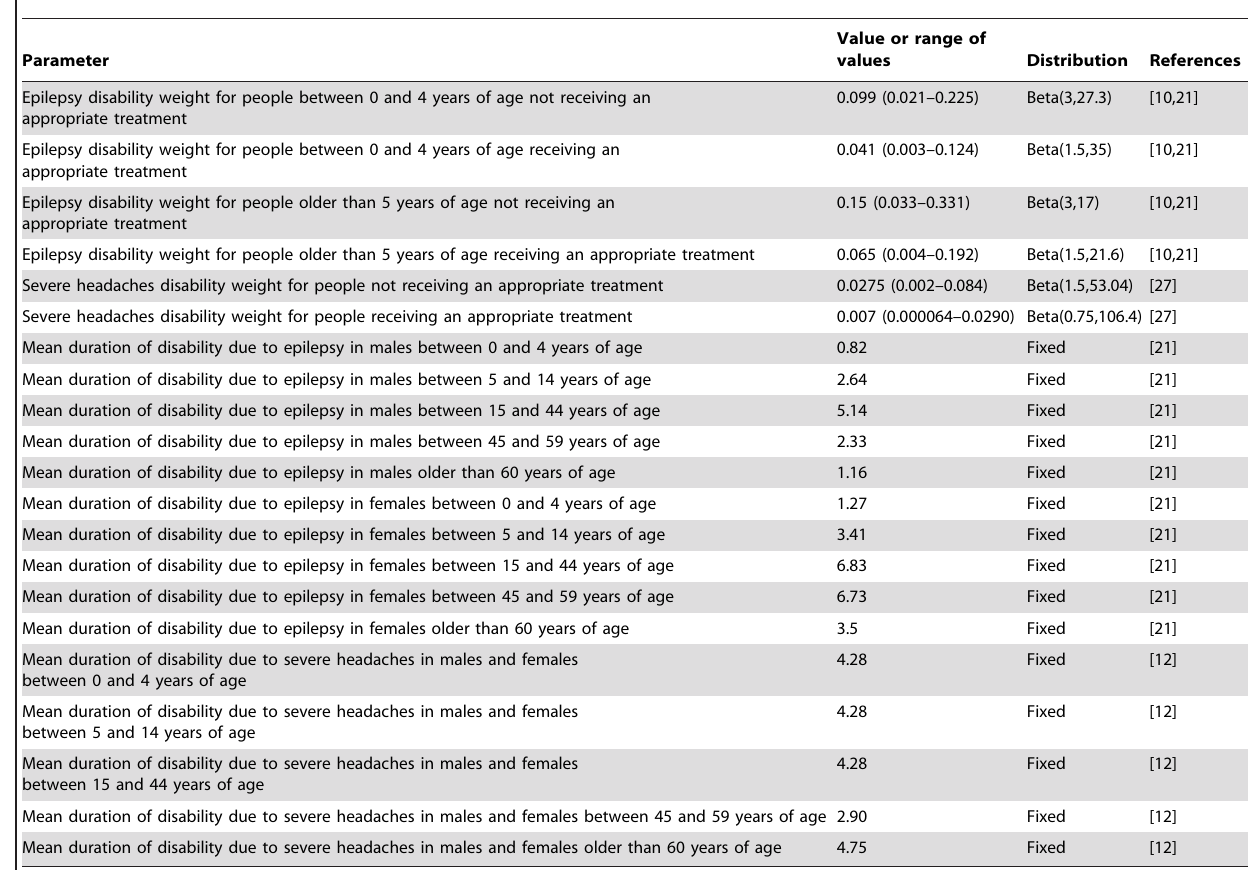
Table 2. Disability weights and durations used to calculate NCC-associated DALYs in